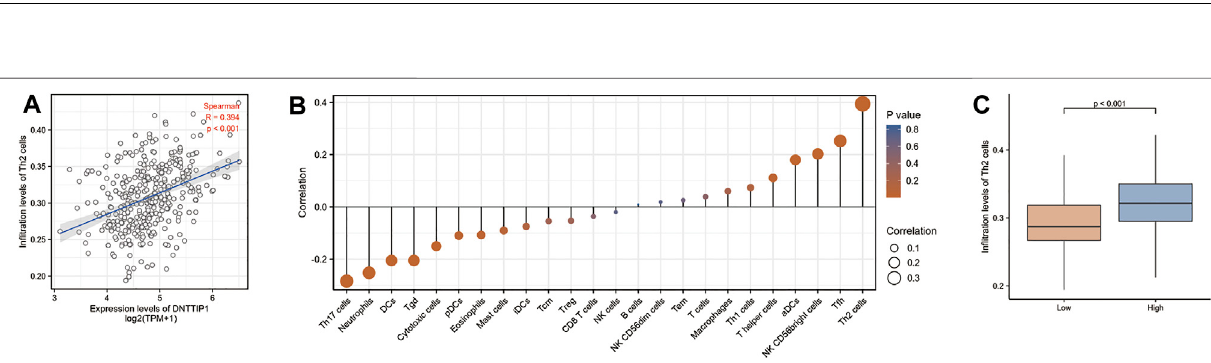
FIGURE 2 | Enrichment analysis of DNTTIP1 in HCC. (A) Top 20 biological process enrichment related to DNTTIP1-related genes with enrichment heatmap. (B) Network of DNTTIP1 and its potential coexpression genes in DNTTIP1-related DEGs. (C – H) Results of enrichment analysis from GSEA.